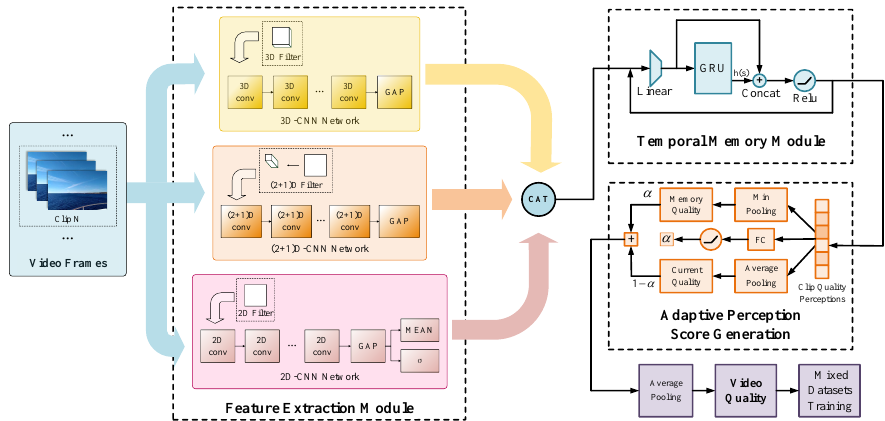
Figure 1. A visual illustration of our proposed multi-dimensional feature fusion network: feature ex- traction module, temporal memory module, and adaptive perception score generation